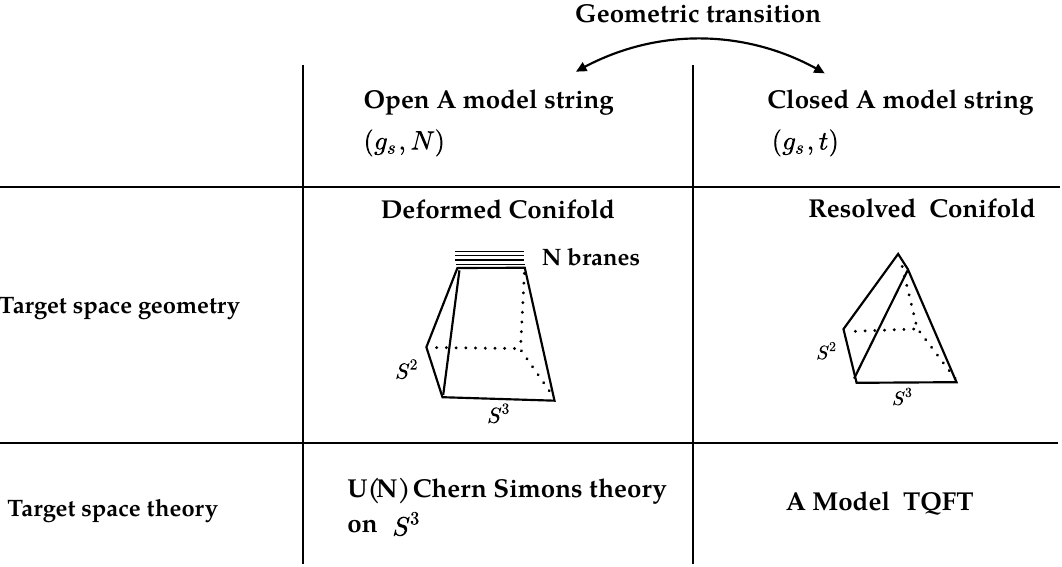
Figure 4 . Gopakumar-Vafa duality relates closed A-model string on the resolved conifold to the open A-model string on the deformed